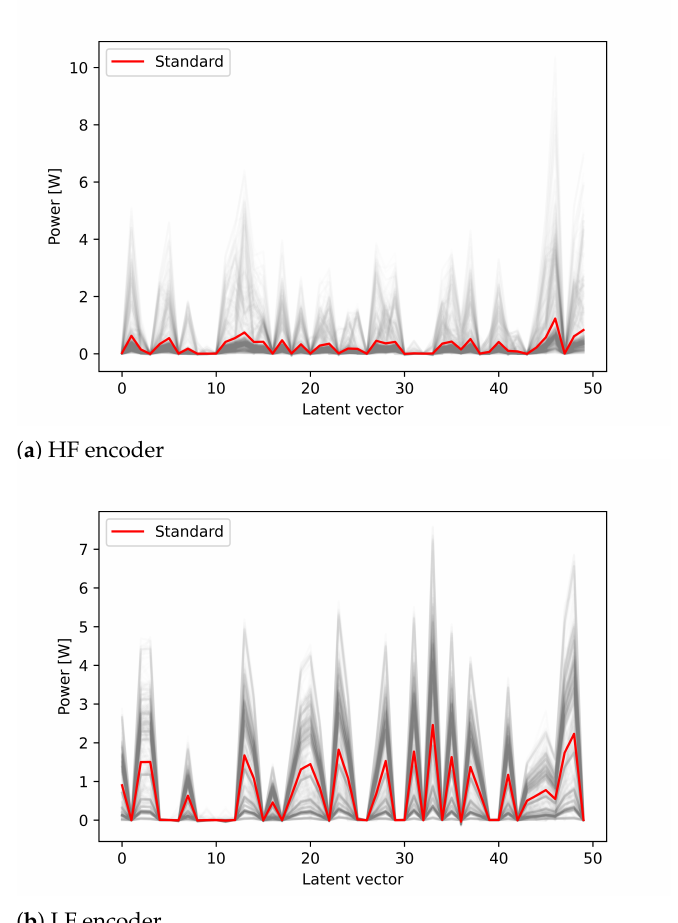
Figure 8. Patterns of averaged power versus latent vector after compression using the